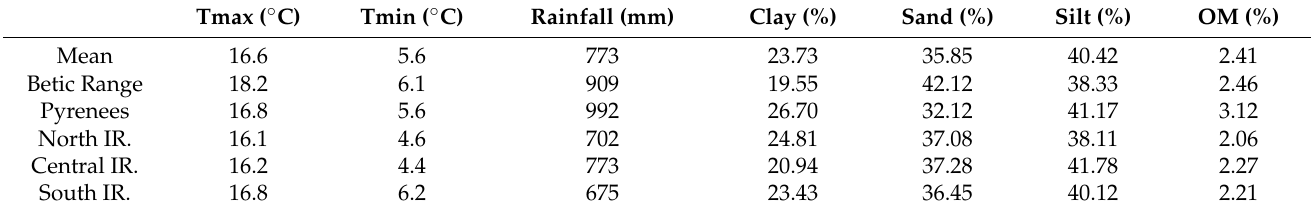
Table 1. Climate variable and soil characteristics values for the study area. *IR corresponds to Iberian Range.